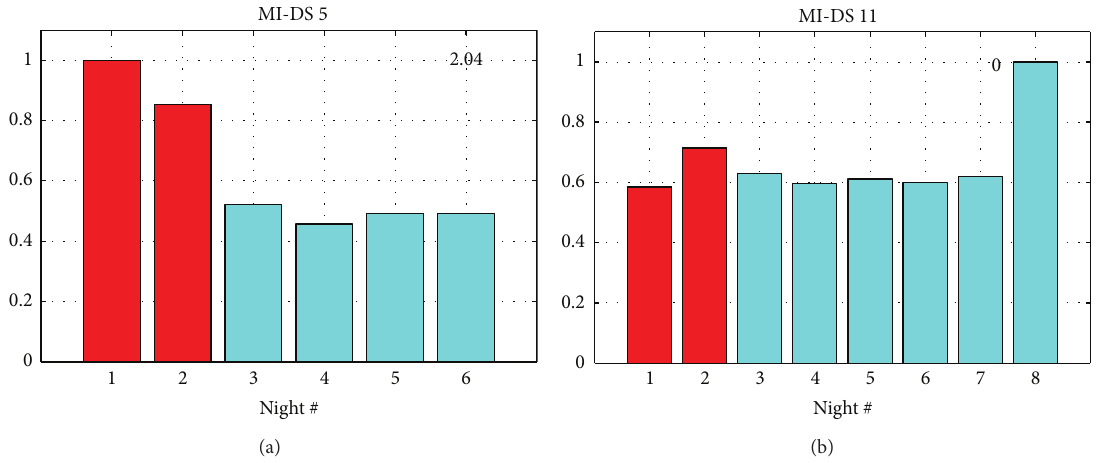
Figure 7: MI computed for datasets (a) DS 5 (poor performance) and (b) DS 11 (missed